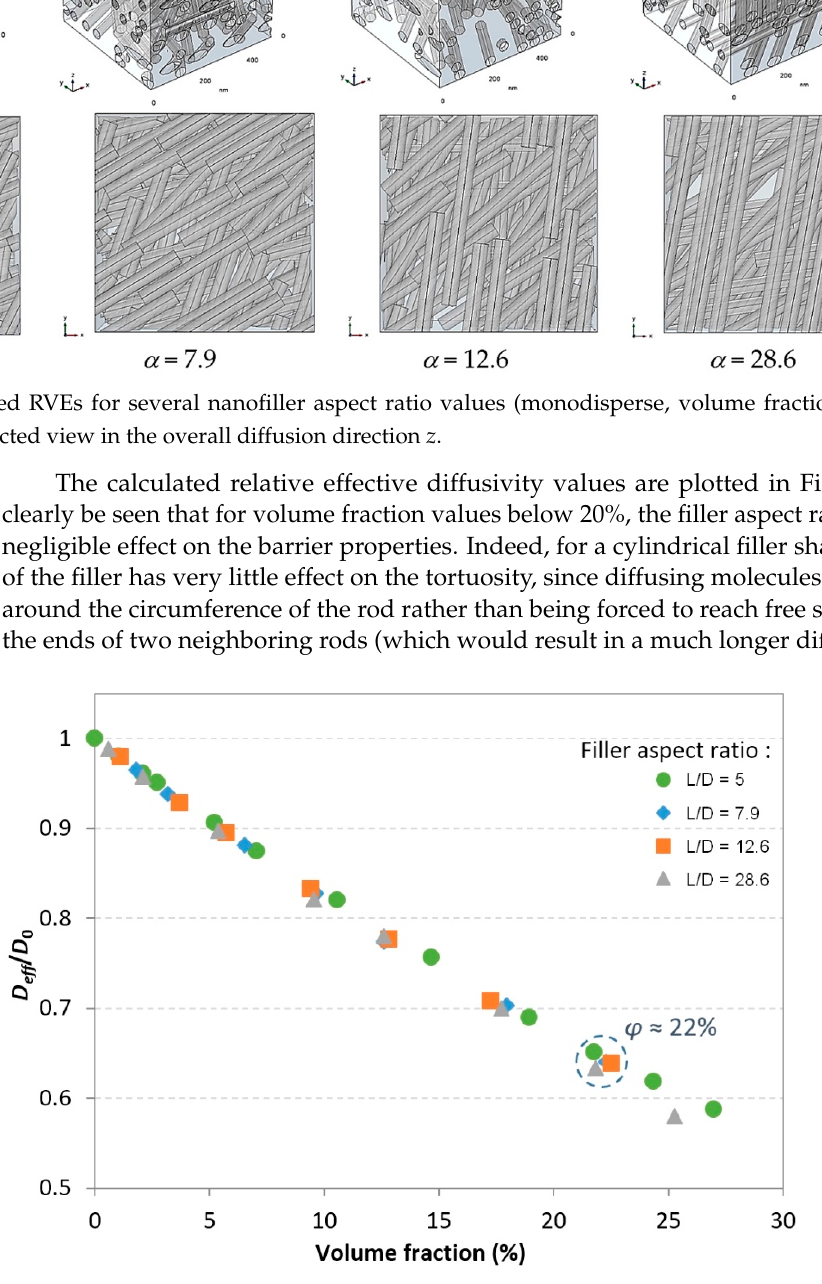
Figure 6. Effects of the filler aspect ratio on the relative effective diffusivity for monodisperse fillers.